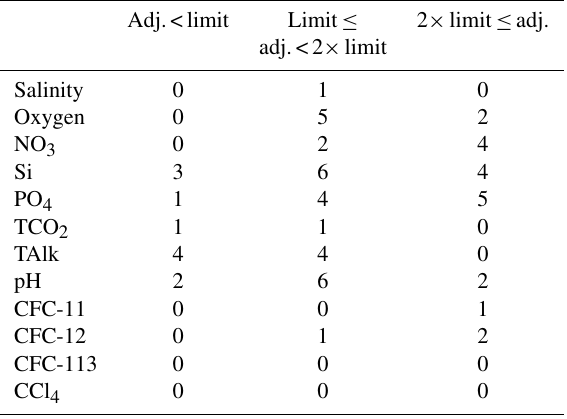
Table 6. Summary of the distribution of applied adjustments per variable, in number of adjustments applied for each